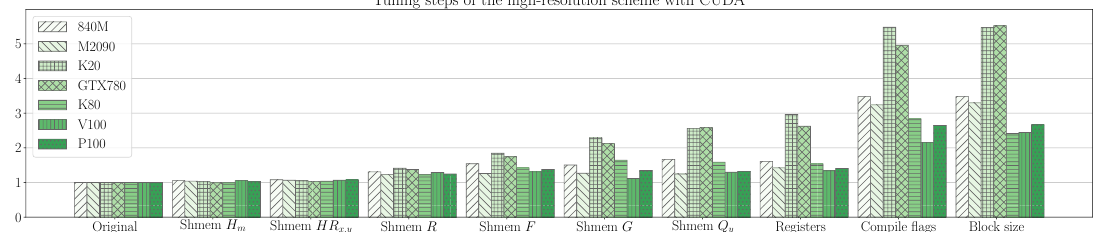
Figure 4. Different optimization stages for the high-resolution kernel showing performance normalized with respect to the original version. Notice that the different optimization strategies impact the performance very differently for different architectures. The platform we profiled on was the 840M GPU, yet the highest performance gain was for the K20 and GTX780 GPUs with over 5